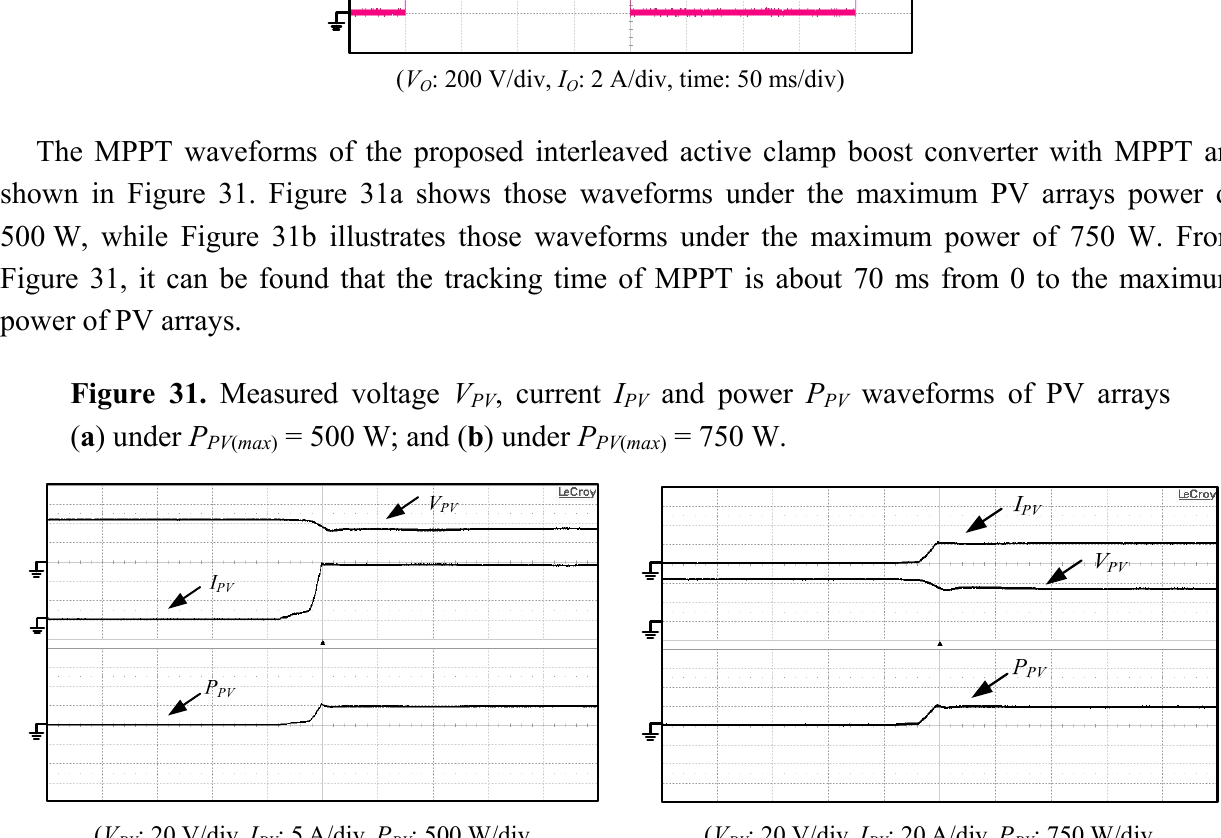
( V : 20 V/div, I PV